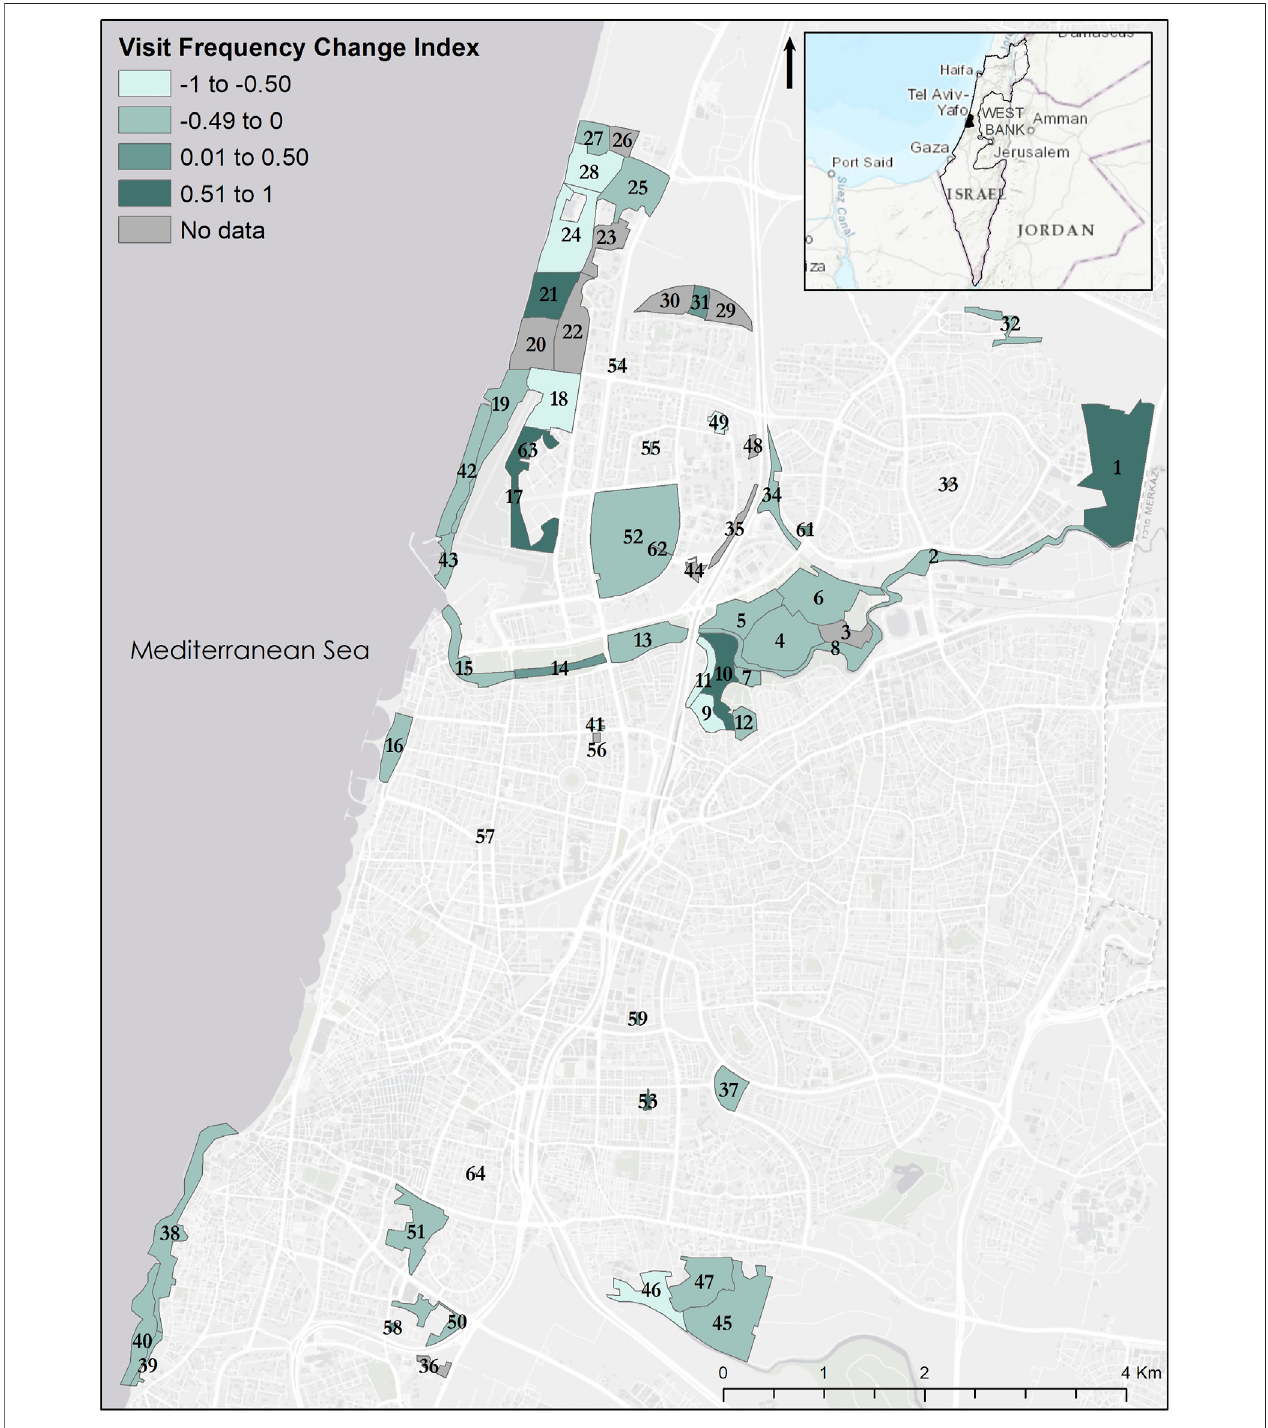
FIGURE1| UrbannaturesitesinTelAviv-Yafo( n =64)withtheaveragevisitfrequencychangeindexforbeforeandduringtheCOVID-19pandemic.Sitenamesare provided in Supplementary Material S1 .